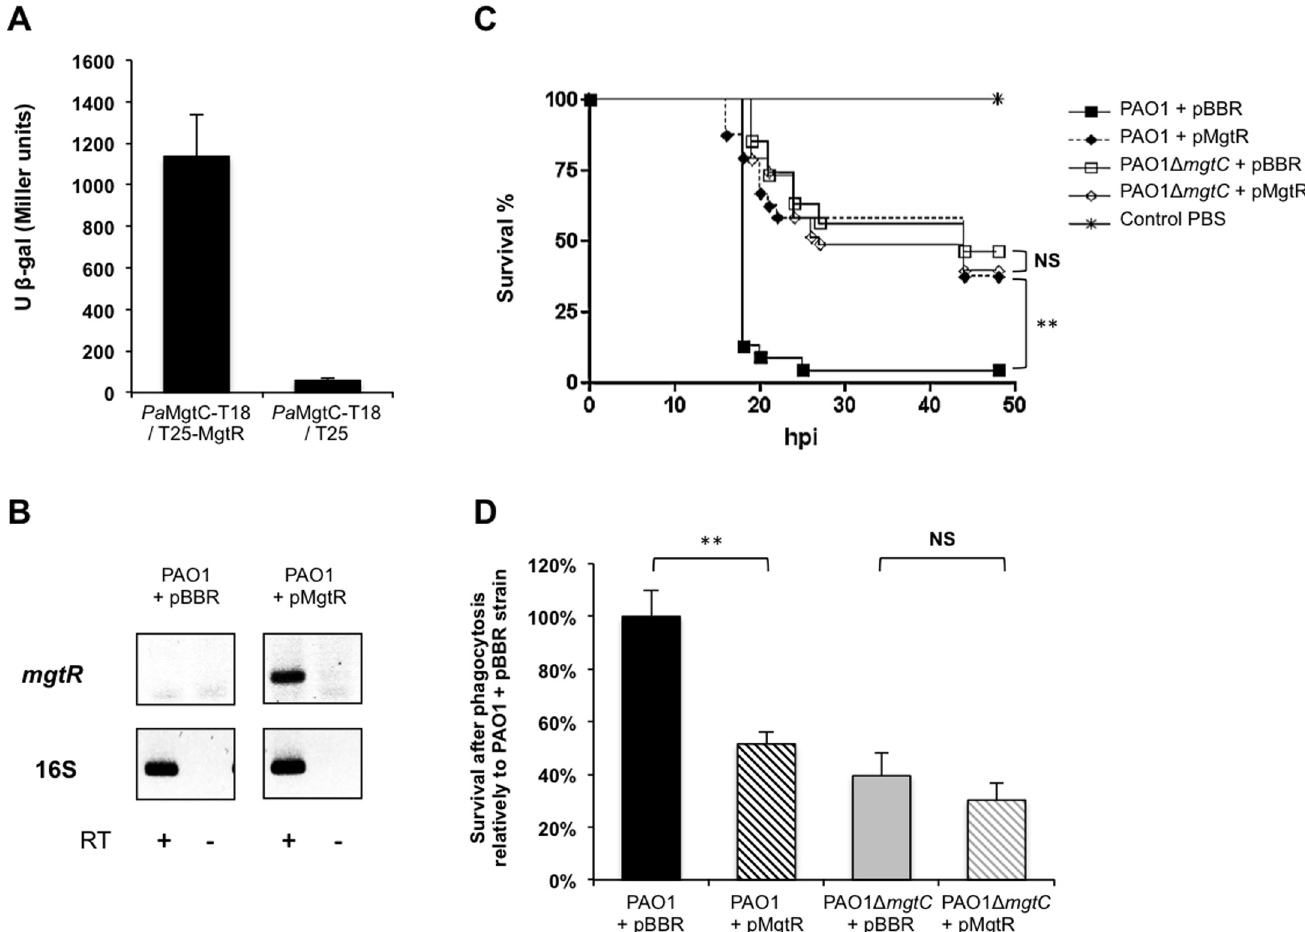
Fig 8. Virulence phenotypes of a PAO1 strain expressing mgtR . ( A) In vivo interaction of Pa MgtC with MgtR peptide. The interaction was assayed using the BACTH system by transforming E . coli BTH101 cells with plasmids producing Pa MgtC-T18 and T25-MgtR. Liquid β -galactosidase assays were performed from six independent experiments. As negative control, BTH101 bacteria were cotransformed with a plasmid expressing Pa MgtC-T18 and the pKT25 vector. Error bars represent SD. (B) Expression of Salmonella mgtR in PAO1 strain. RT-PCR experiment was performed with primers specific for mgtR gene from RNA isolated from PAO1 strain carrying the pBBR1MCS vector (pBBR) or a pBBR1MCS derivative that encodes mgtR (pMgtR). Primers specific for 16S gene were used as positive control. Controls where reverse transcriptase was omitted are indicated (RT-). (C) Survival curve of embryos infected with PAO1 strain expressing or not mgtR . PAO1 Δ mgtC strain expressing or not mgtR is also included in the experiment and non-injected embryos were used as control. Approximately 600 – 1000 CFU of P . aeruginosa were microinjected into the caudal vein (n = 24 per group). Results are expressed as the percentage of surviving on hour post-infection (hpi). Representative results of at least three biologically independent replicates are shown. Embryos are significantly more resistant to infection with PAO1 strain expressing mgtR than PAO1 strain with empty vector ( P < 0.01). (D) Behaviour of the PAO1 strain expressing mgtR in J774 macrophages. PAO1 Δ mgtC strain expressing or not mgtR is included in the experiment. Results are normalized to 100% for the PAO1-pBBR strain and are expressed as means +SE from four independent experiments. Asterisks indicate statistical significance ** P < 0.01). NS, non